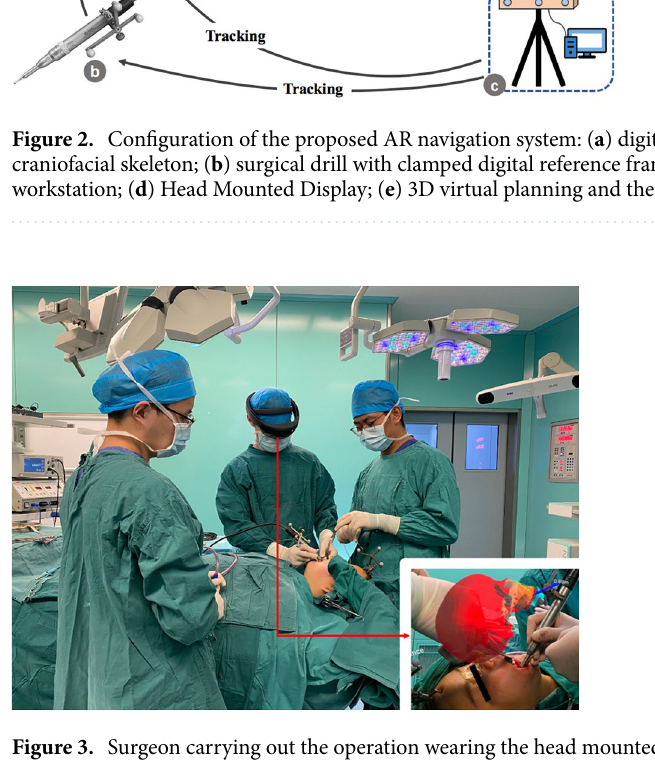
Figure 3. Surgeon carrying out the operation wearing the head mounted